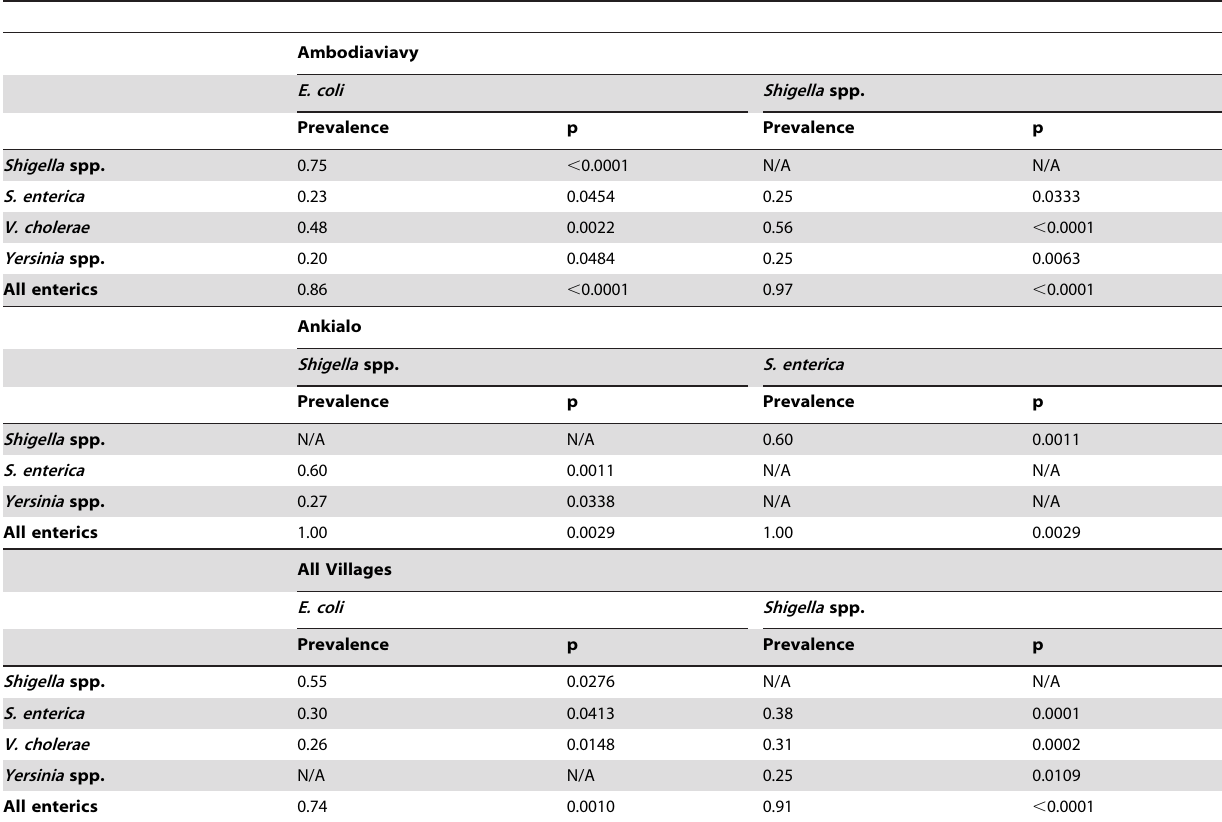
Table 5. Prevalence of Enterobacteriaceae co-infections in humans from villages in Southeastern